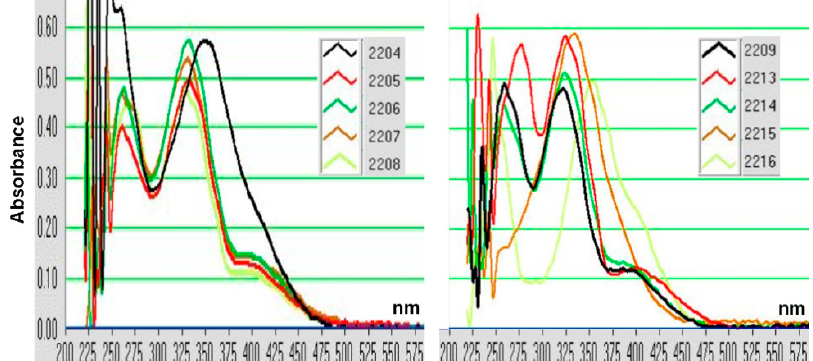
Figure 10 . Absorbance spectra of GIF compounds (5 μ M in PBS). Figure 10. Absorbance spectra of GIF compounds (5 µ M in